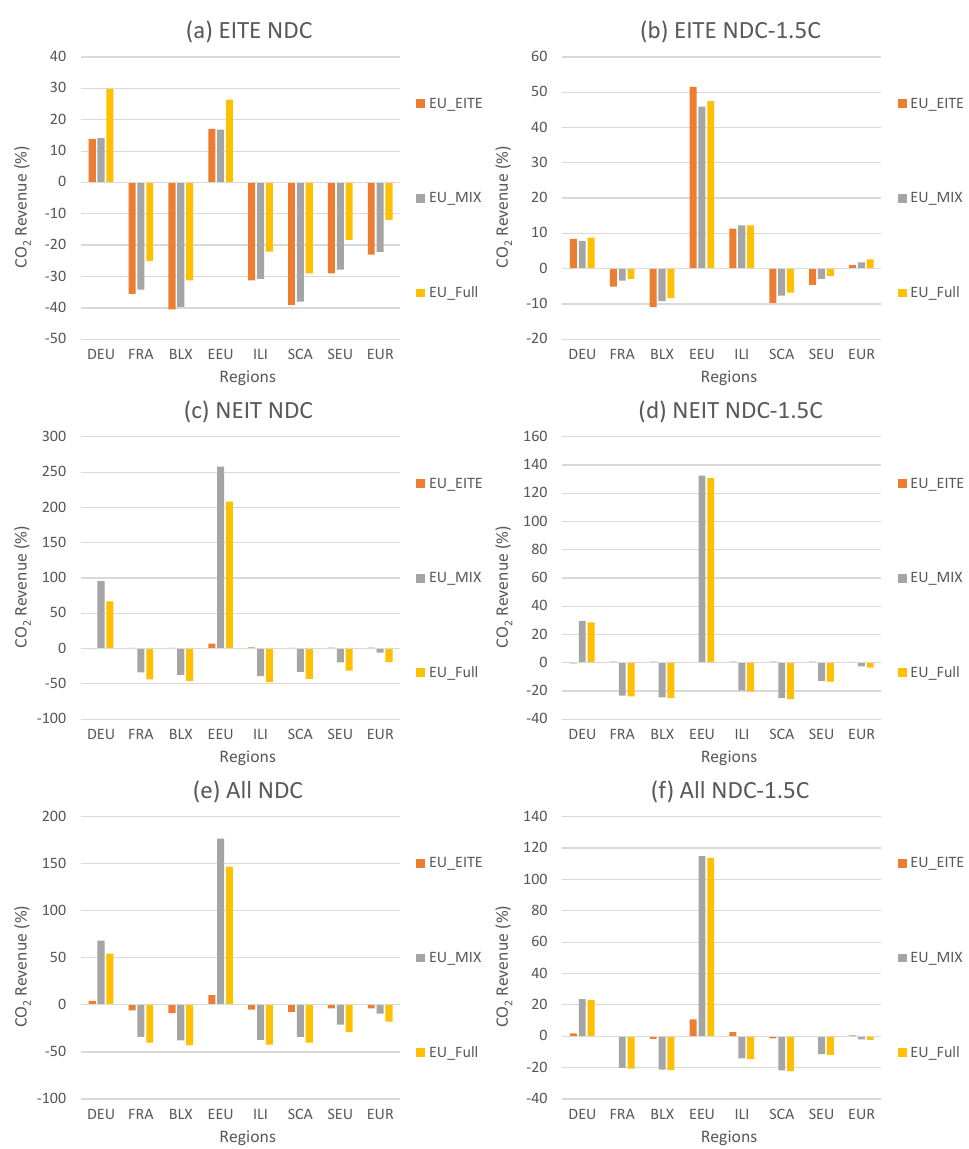
Figure 7. Percentage change in CO 2 revenues in EITE, NEIT, and ALL sectors with regard to CO 2 revenues in the REF scenario for different policy scenarios and NDCs using the IEO baseline.